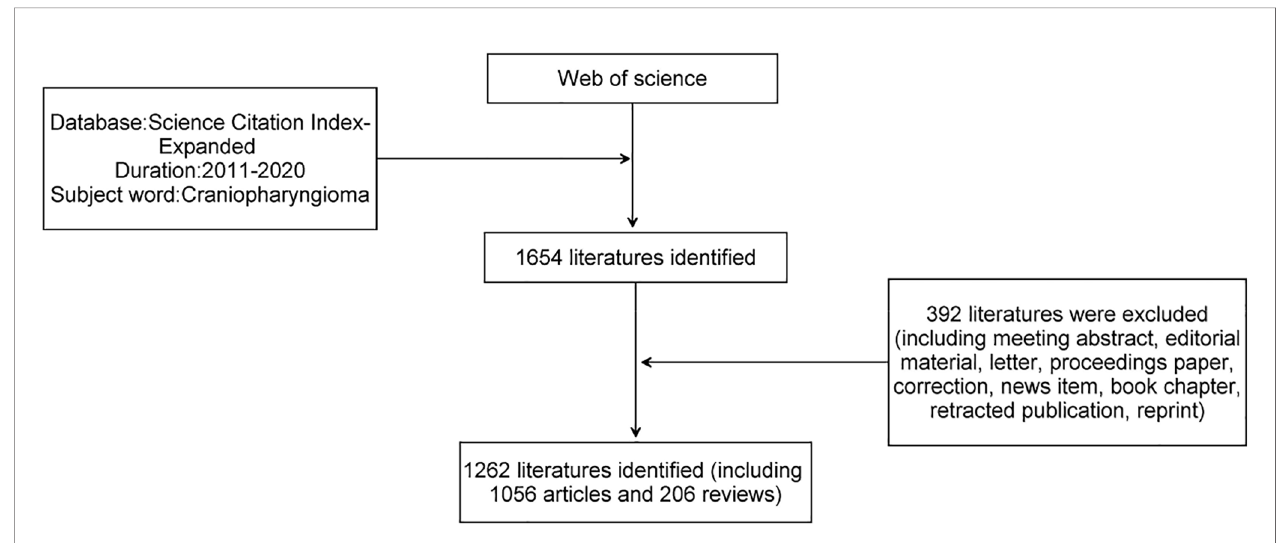
FIGURE 1 | Flow chart of literature fi